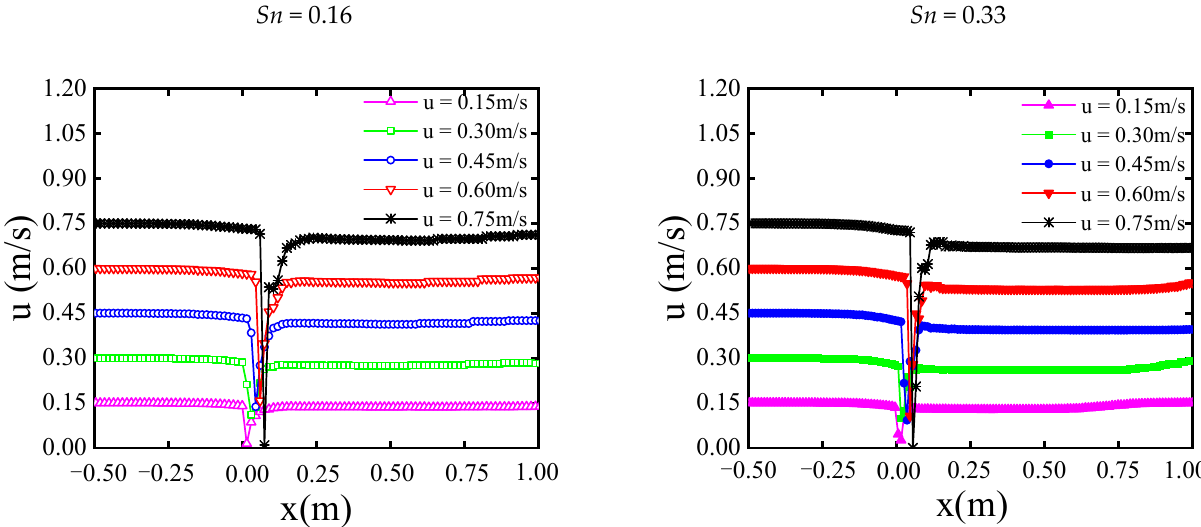
Figure 7. The magnitude of the flow velocity 𝑢 along the centerline of the net panel at different velocities (the 0.0 m along the x-axis denotes the center-line of the net). To estimate the velocity reduction caused by the net’s shielding effect, Løland [48] proposed a linear correlation between the velocity reduction factor and the drag coeffi- cient. That is, 𝑟 = 1 − 0.46𝐶 (cid:3005) , where 𝑟 is the velocity reduction factor. This linear corre- lation indicates that the velocity reduction decreases linearly with the drag coefficient. In